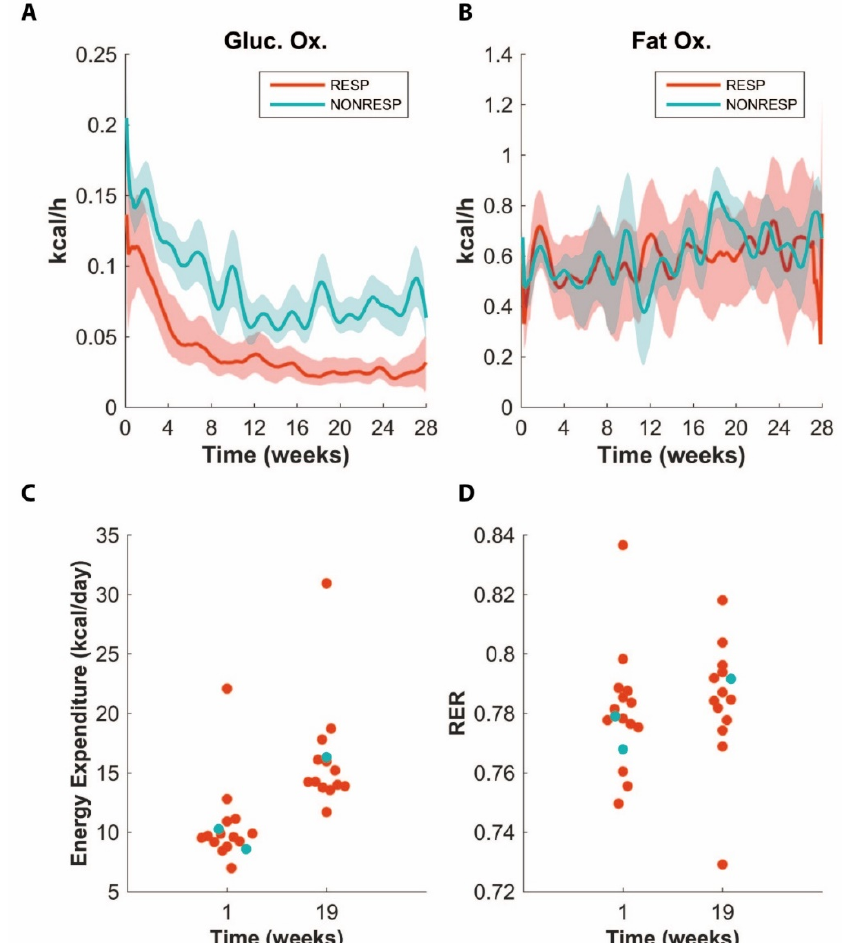
Figure 4. Predictions for glucose oxidation (Gluc. Ox.) ( A ) and fat oxidation (Fat Ox.) rate ( B ) in responders and non-responders, respectively. The line represents the median values, whereas the area around the line denotes 30% of solutions around the median. Energy expenditure ( C ) and respiratory exchange ratio (RER) ( D ) for animals after 1 and 19 weeks of HFCDs. Note how the non-responders (blue) are not necessarily marked by increased energy